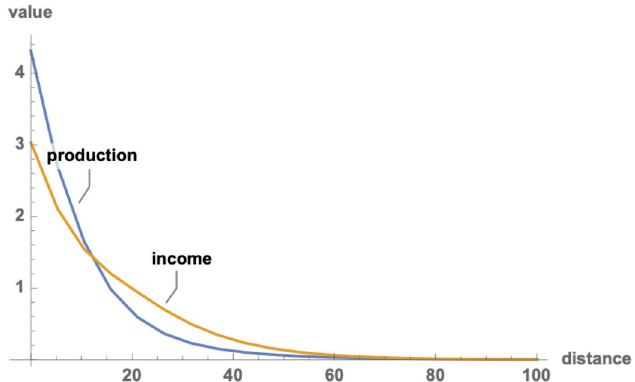
Fig 3. Wealth-power mismatch. Average outcomes for all possible combinations of 3 person games among 20 players along a line in space (arbitrary distance units; games among nearby players weighted more heavily). Resources fall off exponentially with from core to periphery. Central players produce more than they get; more distant players get more than they produce.